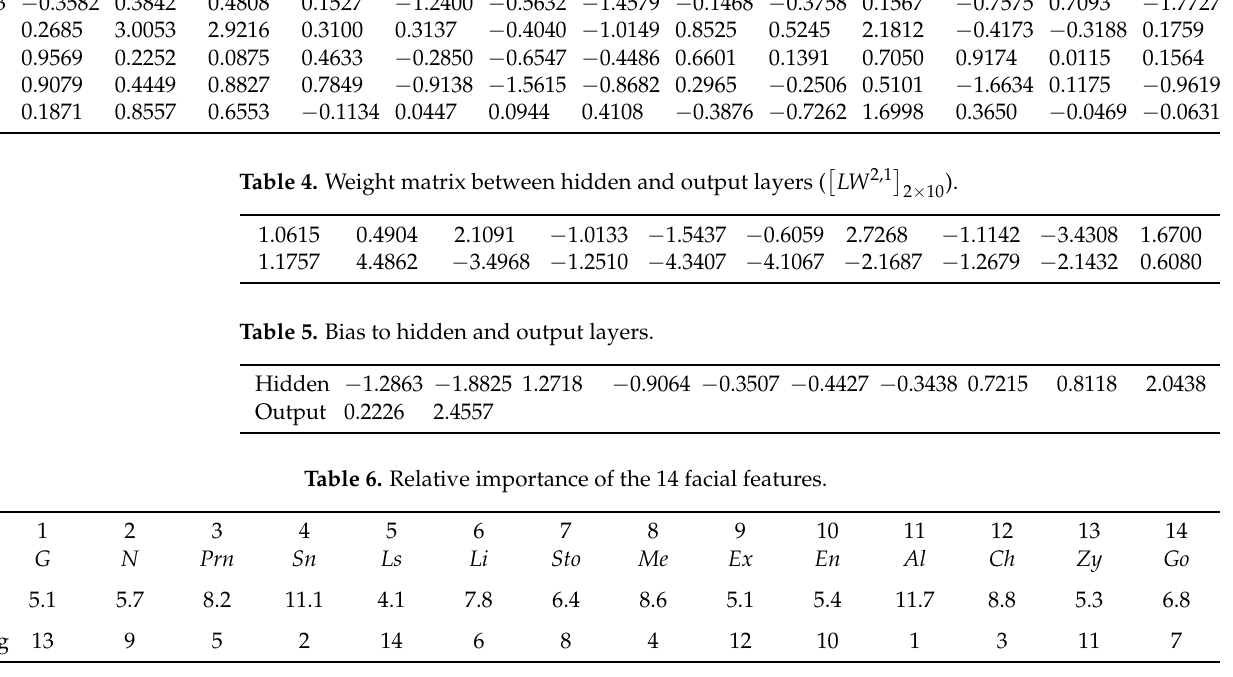
Table 3. Weight matrix between input and hidden layers (